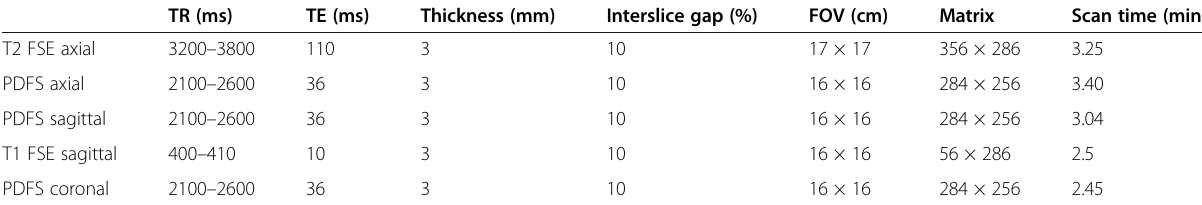
Table 1 MRI protocol for evaluation of the